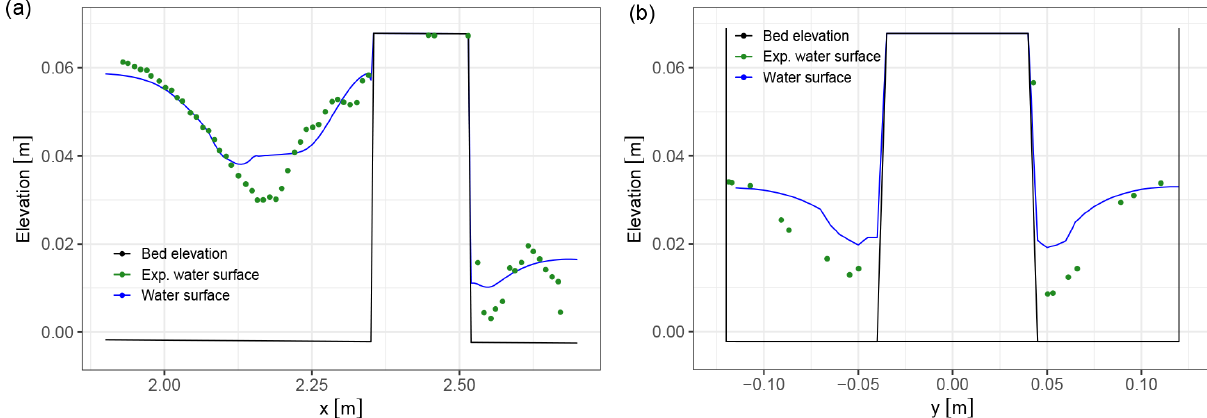
Figure 9. Simulated and experimental steady water surface in the obstacle region of the G3 flume for the centreline profile y = 0m (a) and a cross-section x = 2.40m (b) .